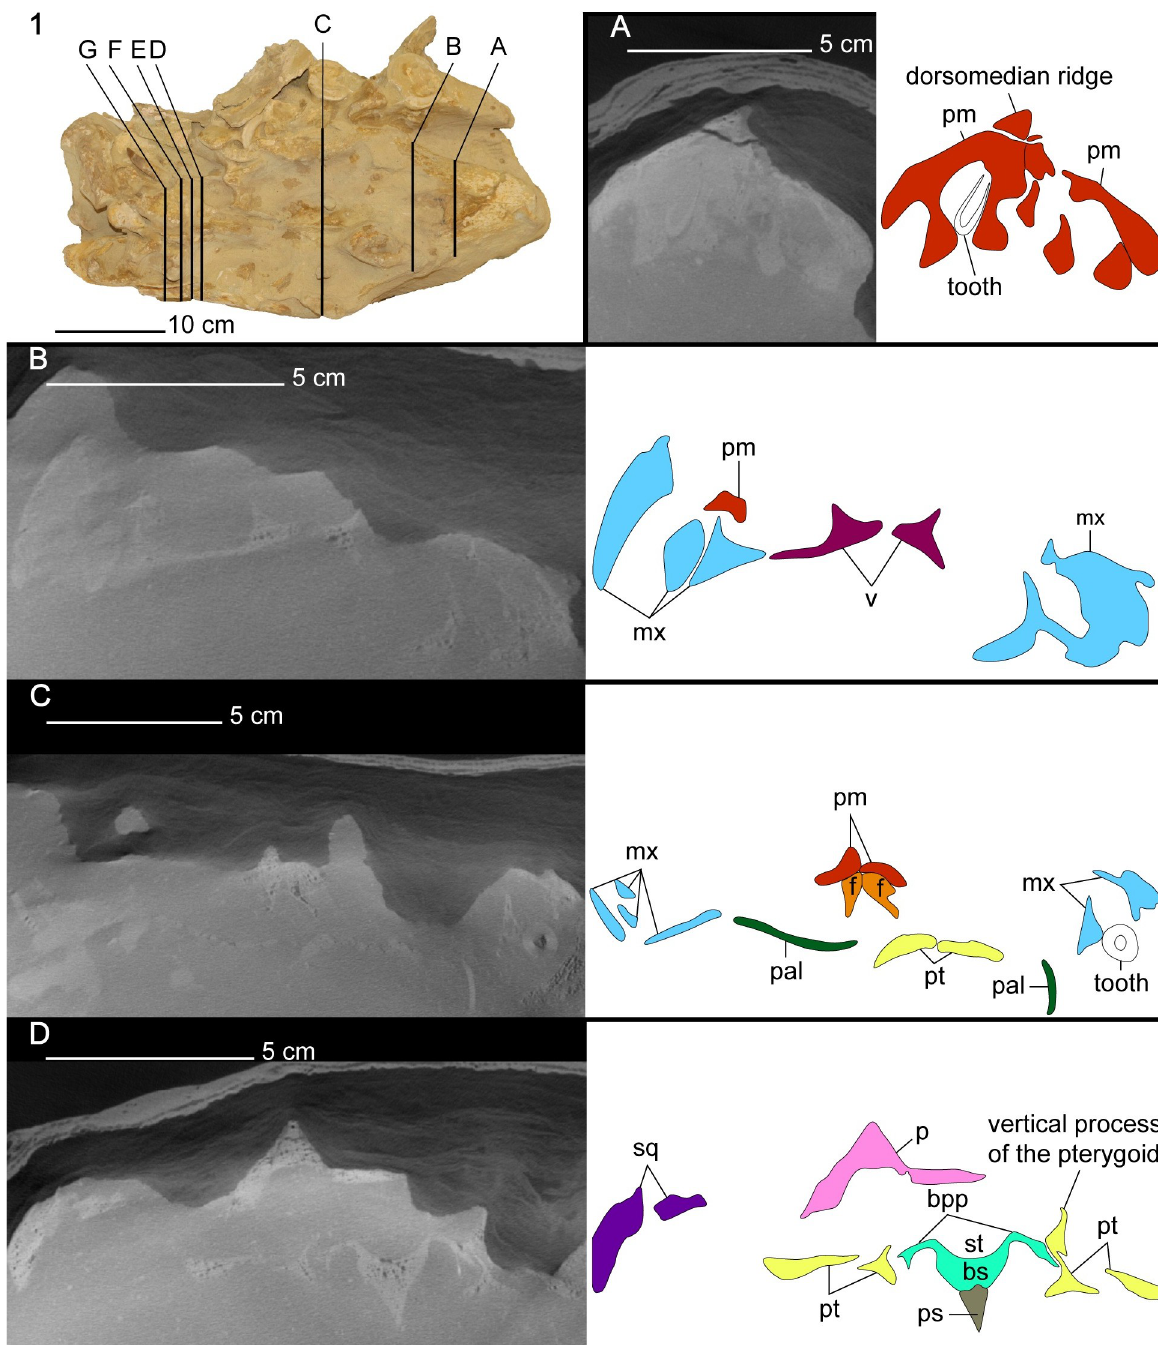
Fig 8. CT cross-section images of the cranium of Cardiocorax mukulu (MGUAN PA278). A. Transversal section through the third pair of premaxillary alveoli. B. anterior margin of the palate. C. Section of intraorbital region of the cranium. D. Section through the anterior margin of the sella